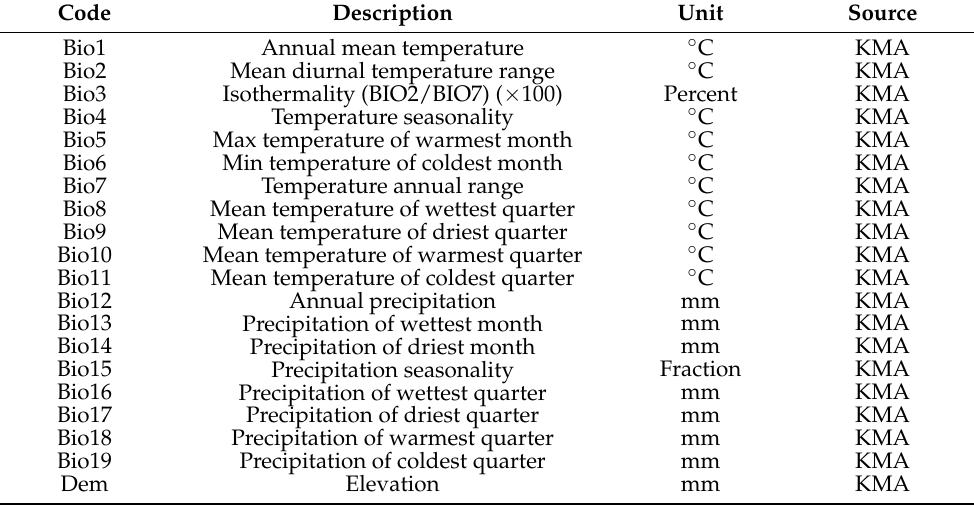
Table 2. Bioclimatic and environmental variables used in this